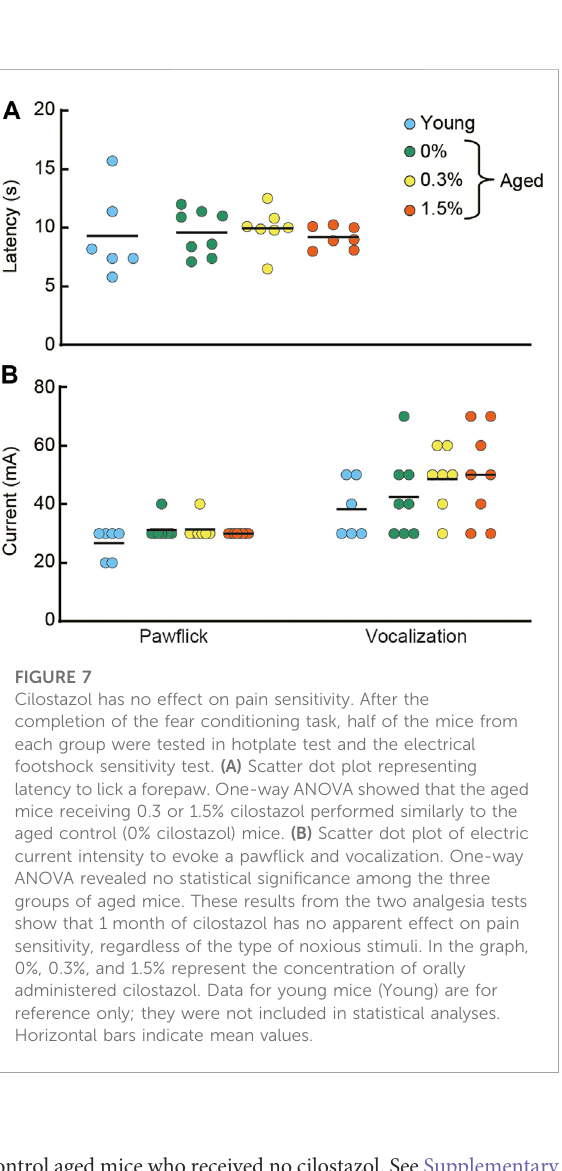
Figure S1 for other brain regions analyzed. PET scan data (Figure 9B) for the aged control (0% cilostazol) mice and mice receiving 1.5% cilostazol were consistent with our [ 18 F] FDG uptake data (Figure 9A). Several high-uptake areas were observed, a prominent one being the midbrain including hippocampus (Figure 9B). The results suggest that overall